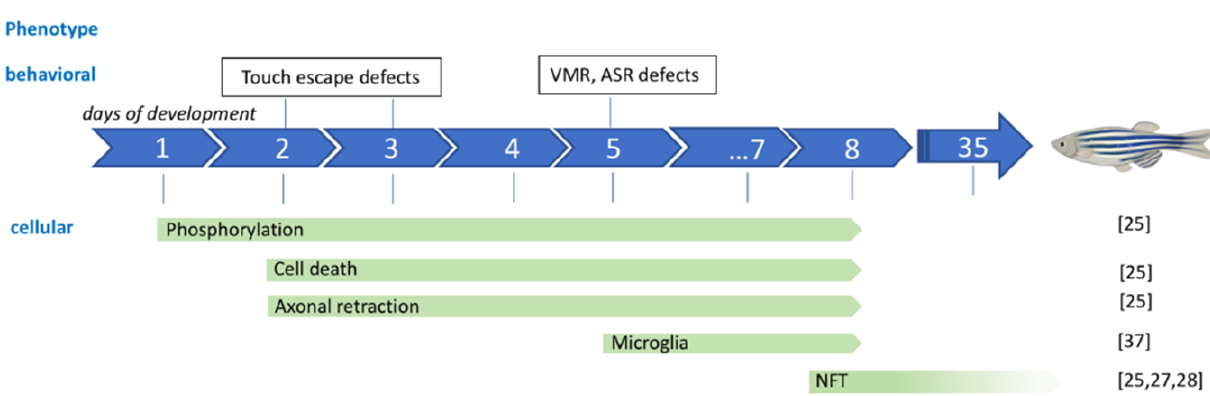
Figure 3. Phenotype evolution during zebrafish development for the hTauP301L mutation. NFT: neurofibrillary tangles; VMR: visual motor response, ASR: acoustic startle response.